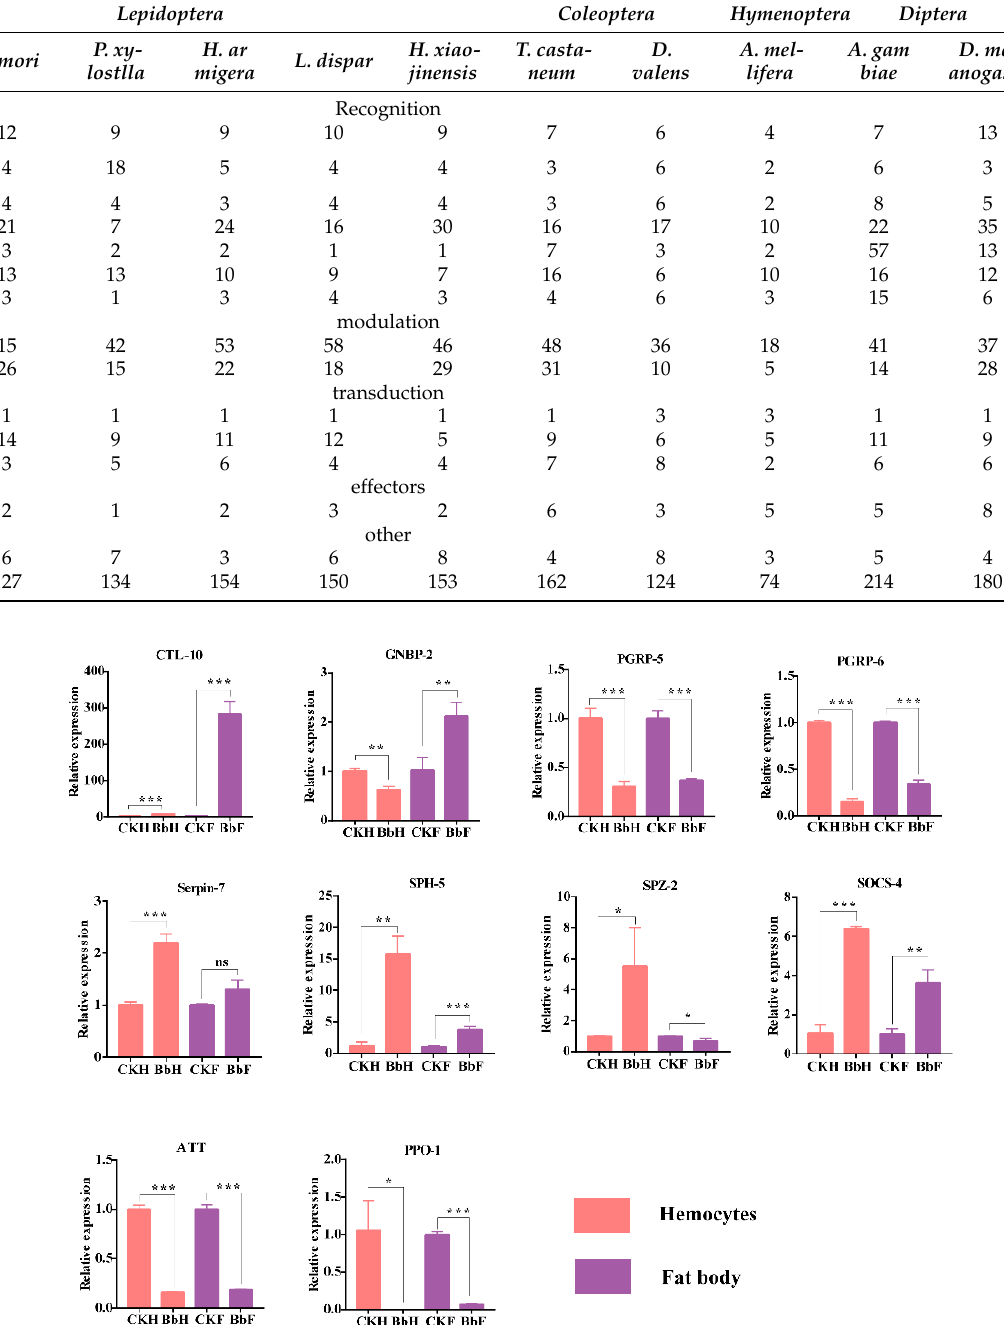
Table 1. Families and counts of innate immune genes from the insects. (The gene counts of B. mori , T. castaneum, A. mellifera , A. gambiae , D. melanogaster were based on genomic data.).